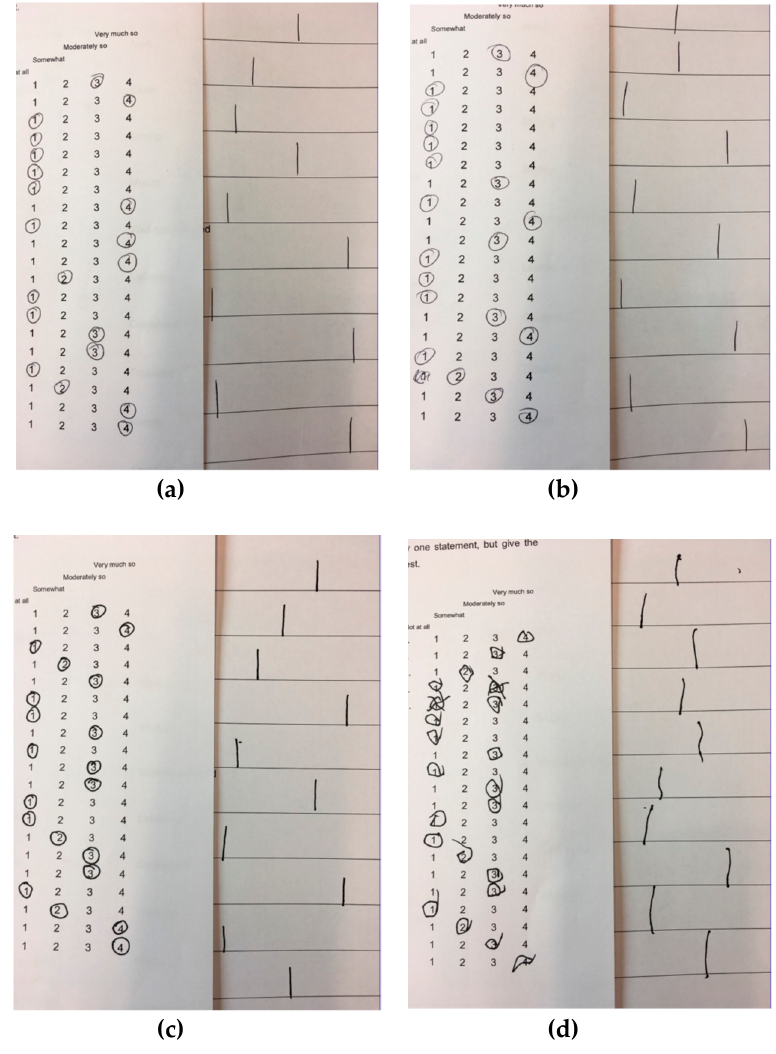
Figure 1. Difficulty in motor coordination and indecisiveness. ( a ) Before placebo Figure 1. Di ffi culty in motor coordination and indecisiveness. ( a ) Before placebo administration; administration; ( b ) After placebo administration; ( c ) Before delta-9-tetrahydrocannabinol ( b ) After placebo administration; ( c ) Before delta-9-tetrahydrocannabinol administration; ( d ) After delta-9-tetrahydrocannabinol administration; ( d ) After delta-9-tetrahydrocannabinol administration.